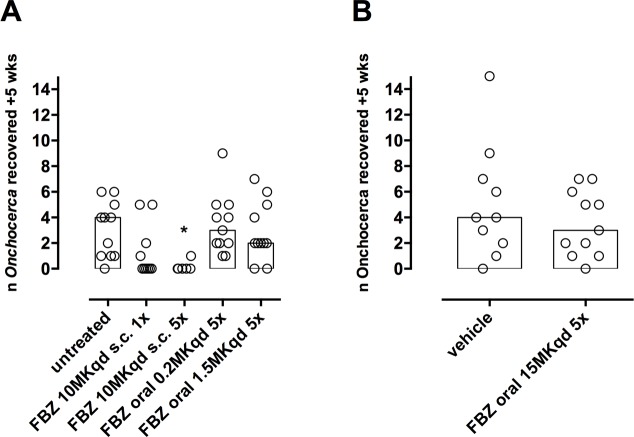
O. ochengi male worm burdens 5 weeks following indicated treatments for experiments (A) and (B). Bars are median recovered numbers per group. Treatment with s.c. injected FBZ 10mg/kg qd 5x mediated a significant reduction in the retrieval of viable O. ochengi worms (Kruskal-Wallis ANOVA = 15.45, Dunn’s tests untreated vs FBZ 10mg/kg qd 5x P<0.05*).